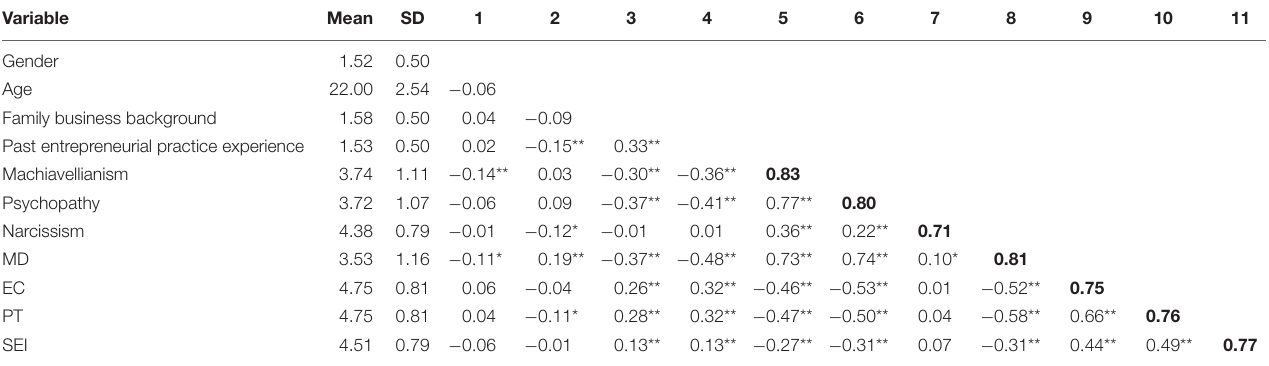
TABLE 1 | Mean, standard deviation, Pearson zero-order correlation, and the discriminant validity test for Study 1.